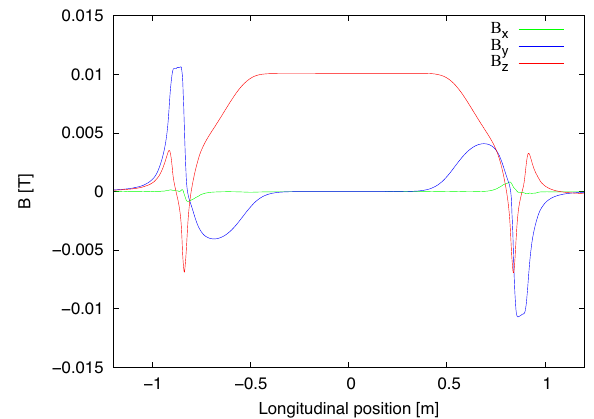
FIG. 1. The magnetic field components of the electron cooler plotted against the longitudinal position with transverse coor- dinates x ¼ y ¼ 2 cm referenced to the design